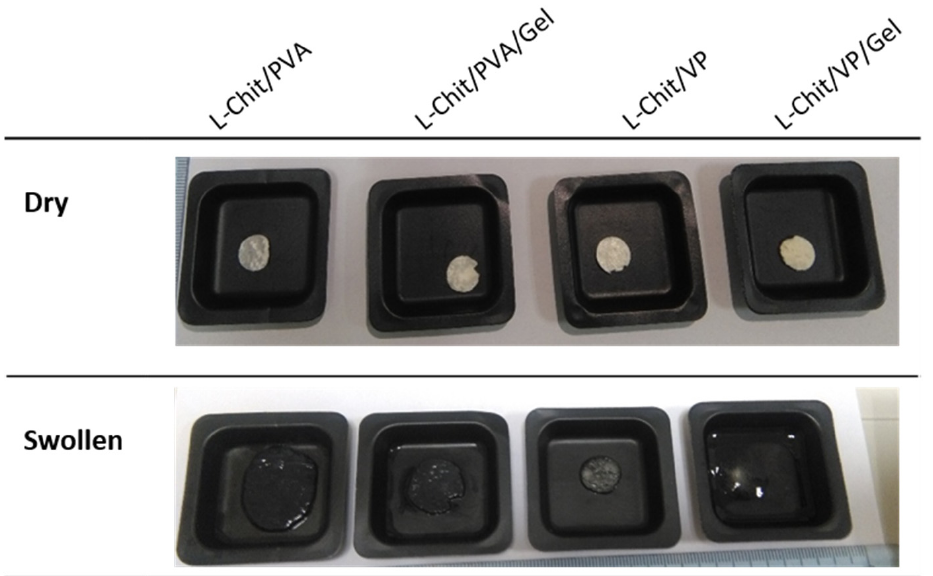
Figure 4. Macroscopic view of low-Mw chitosan-based membranes γ -irradiated at 10 kGy in dry and swollen state after 2 h immersed in distilled water.